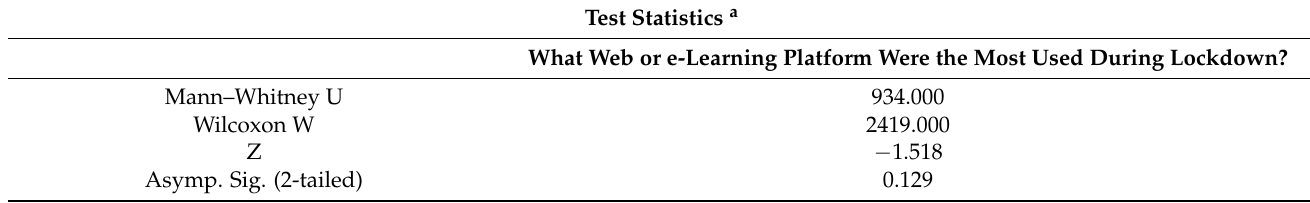
Table 1. Mann–Whitney test for web platforms, by role Test Statistics